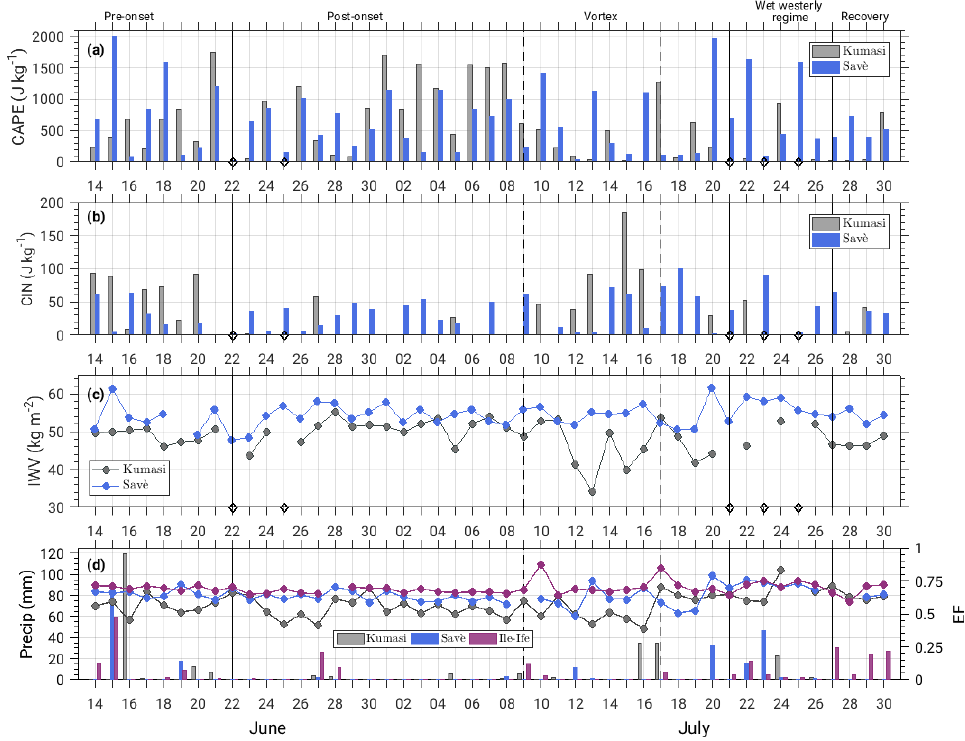
Figure 4. Time series of CAPE (a) , CIN (b) and IWV (c) from the 06:00UTC radiosonde data for Kumasi and Savè. Diurnal precipi- tation sum and evaporative fraction (EF) for Kumasi, Savè and Ile-Ife are shown in (d) . Diamonds in (a) , (b) and (c) indicate days with missing/incomplete radiosondes in Kumasi. Different phases of the monsoon are indicated according to Knippertz et al.